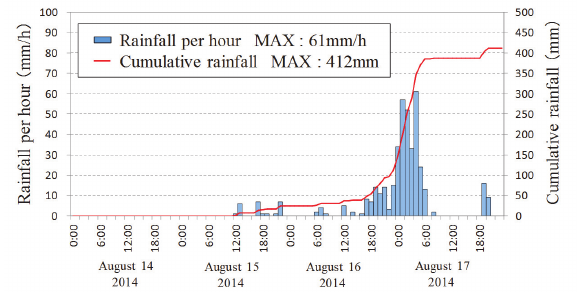
Figure 10. Rainfall history of the target watershed